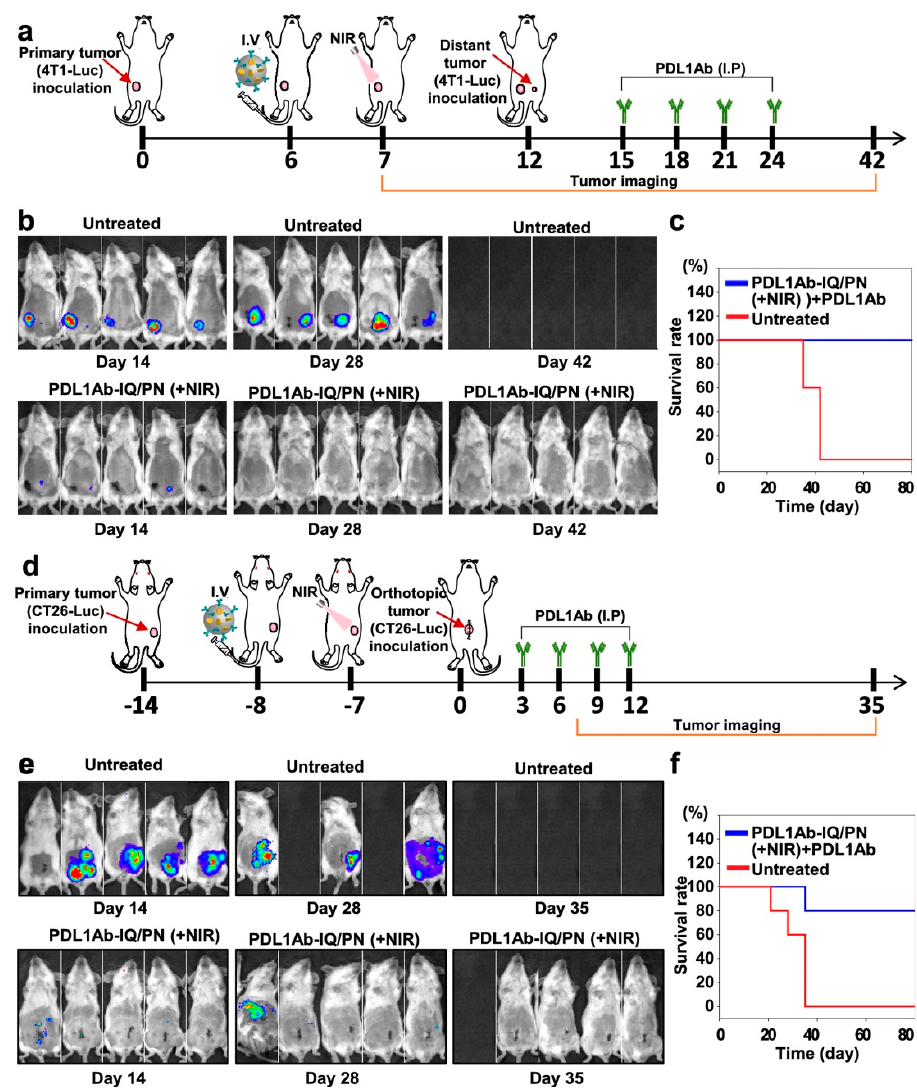
Figure 7. In vivo antitumor efficacy of PDL1Ab-PNs against orthotopic tumors. ( a ) Outline of 4T1 orthotopic breast tumor inoculation and dosing regimen. The 4T1 orthotopic breast tumor-bearing mice were intravenously injected with PDL1Ab-IQ/PNs on day 6 after inoculation and irradiated with an 808-nm laser on day 7. Twelve days after the first tumor inoculation, 4T1 cells were inoculated at a site distant from the primary tumor. In the untreated group, primary tumors were surgically removed on day 18 for observation of distant orthotopic tumor growth. PDL1Ab (100 µg) were administered on days 15, 18, 21, and 24. ( b ) The formation of orthotopic tumors was observed by luminescence imaging. Black panels in images correspond to mice that died. ( c ) Survival rates